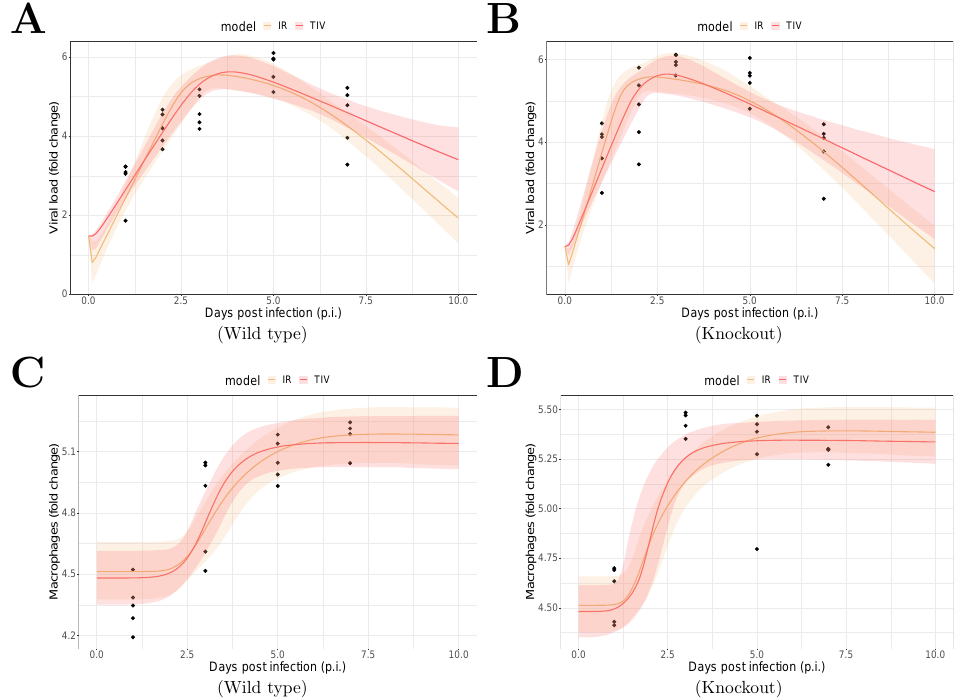
Figure 1. Results of model fitting for WT and MUC1-KO mice. Data are presented by solid circles. 1 Panels ( A , B ) show the median of posterior predictions (solid line) and a 95% prediction interval (shaded area) of viral load data for both TIV (red) and IR (yellow) models for WT and MUC1-KO mice, respectively. Panels ( C , D ) show the model predictions of macrophage data in the two models for WT and MUC1-KO mice, respectively. The priors of model parameters are given in Supplementary Materials. The posteriors of estimated model parameters are given in Supplementary